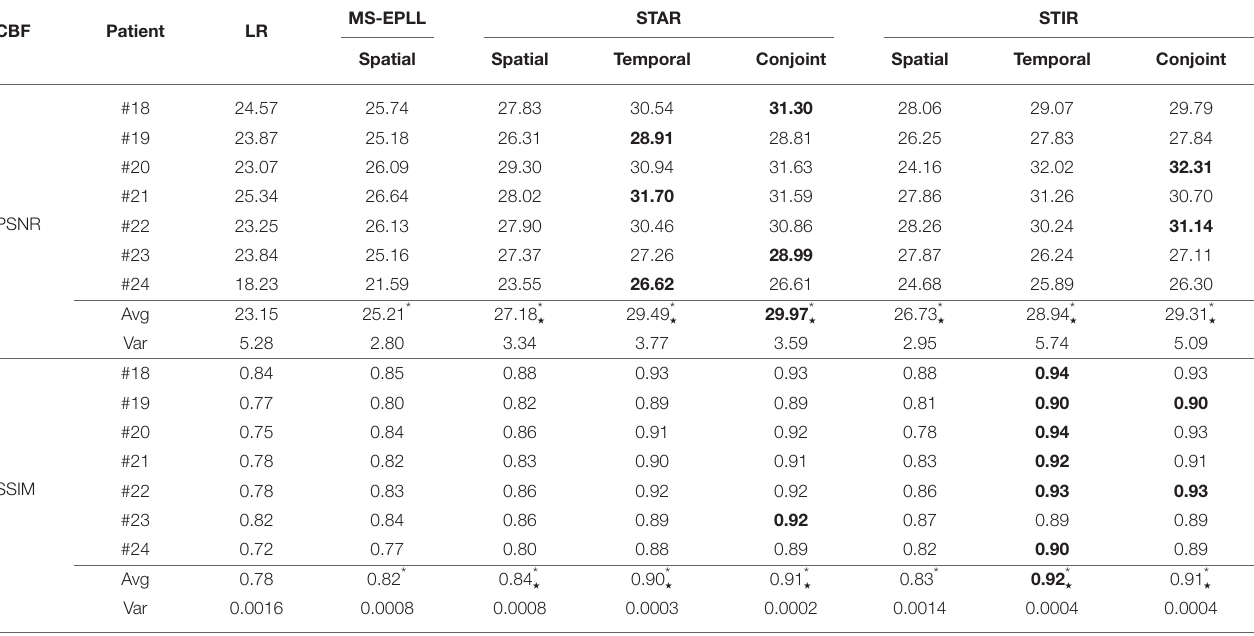
In this table, three methods are compared: MS-EPLL, STAR, and STIR-Net. LR means the PSNR value for the noise image after down-sampling. The best values are highlighted for different patients. The average value and the variance are listed at the bottom of the table. The asterisk symbol denotes the result of the current method achieves significant higher